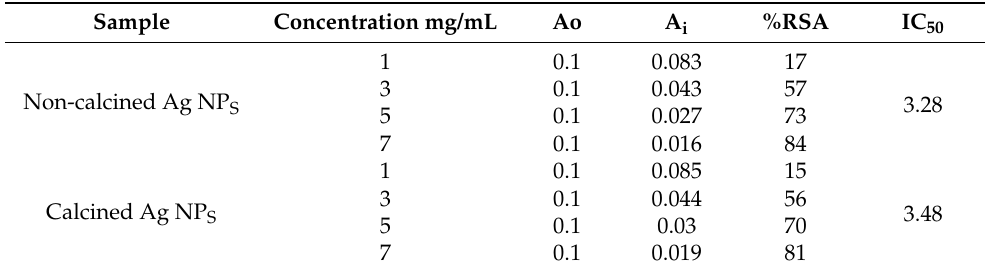
Table 2. Percentage scavenging activity (%RSA) of biogenic non-calcined and calcined Ag NPs and IC 50 from the ABTS